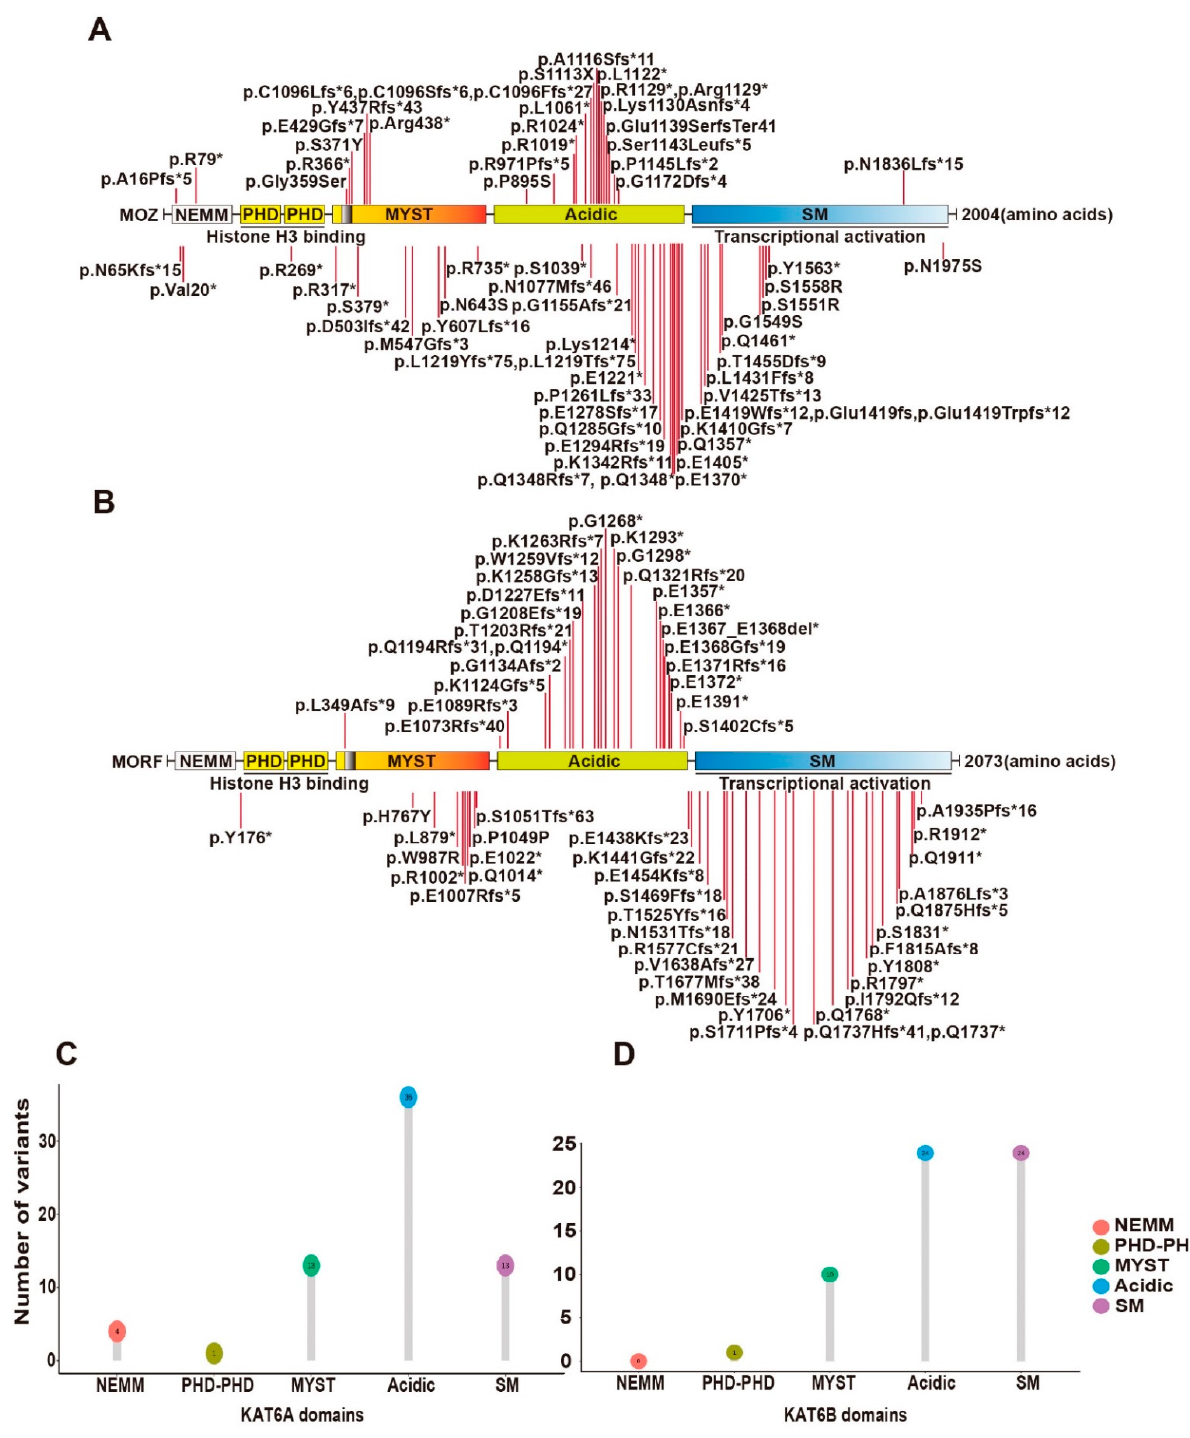
Figure 3. Syndromic intellectual disability-associated KAT6A and KAT6B germline variants. ( A ) Cartoon representation of KAT6A germline mutants identified in patients with intellectual disability. ( B ) Cartoon representation of KAT6B germline mutants identified in patients with intellectual disability. See Figure 1 for domain nomenclature. ( C ) Lollipop graph demonstrating the distribution of syndromic intellectual disability-associated KAT6A variants. Most variations are clustered in the acidic region. ( D ) Lollipop graph demonstrating the distribution of syndromic intellectual disability-associated KAT6B variants. Most variations are clustered in acidic and SM regions.